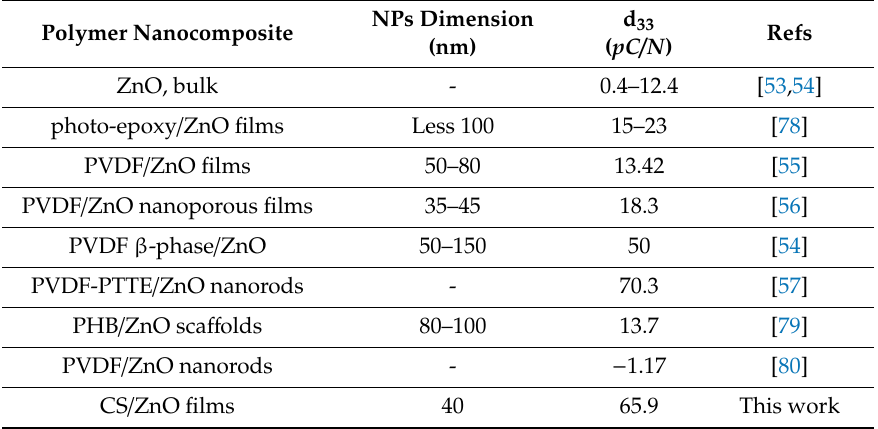
Table 1. Comparison of piezoelectric d 33 values in polymer nanocomposites with ZnO